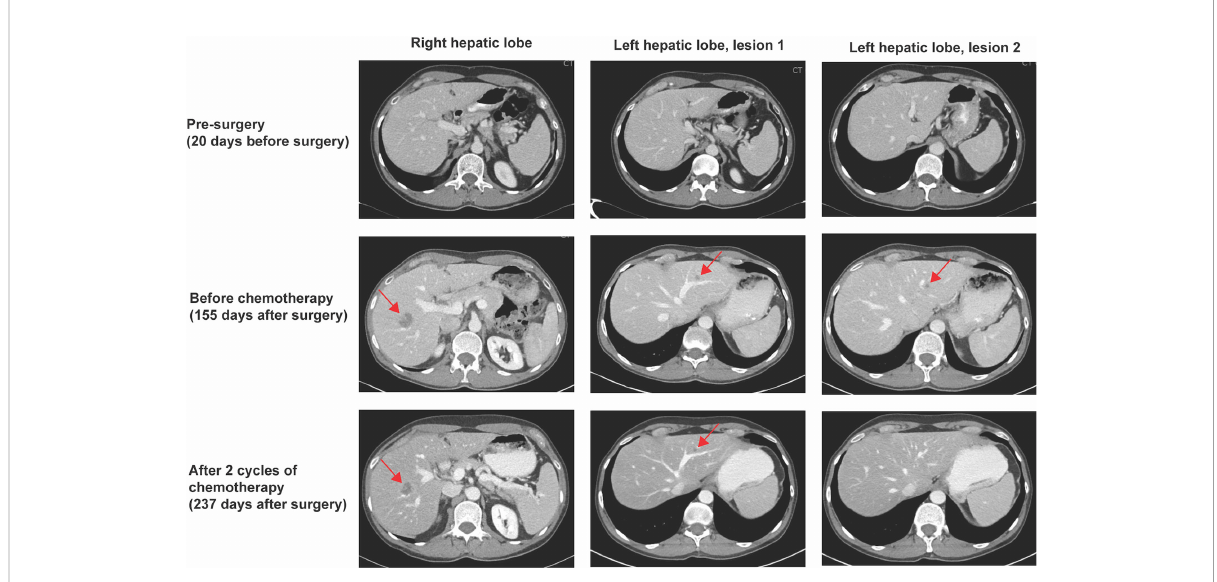
FIGURE 1 CT scan results. CT scan 20 days prior to right hemicolectomy did not show any evidence of metastatic disease (top panel). Rising ctDNA levels prompted a CT scan on post-operative day 155, which revealed a 2.4 x 1.8 cm ill-de fi ned hypoattenuating lesion in the right hepatic lobe, as well as 0.8 cm and 0.4 cm nodules in the left hepatic lobe (red arrows, middle panel). An interval CT scan after two cycles of chemotherapy showed response of all hepatic lesions (red arrows, bottom